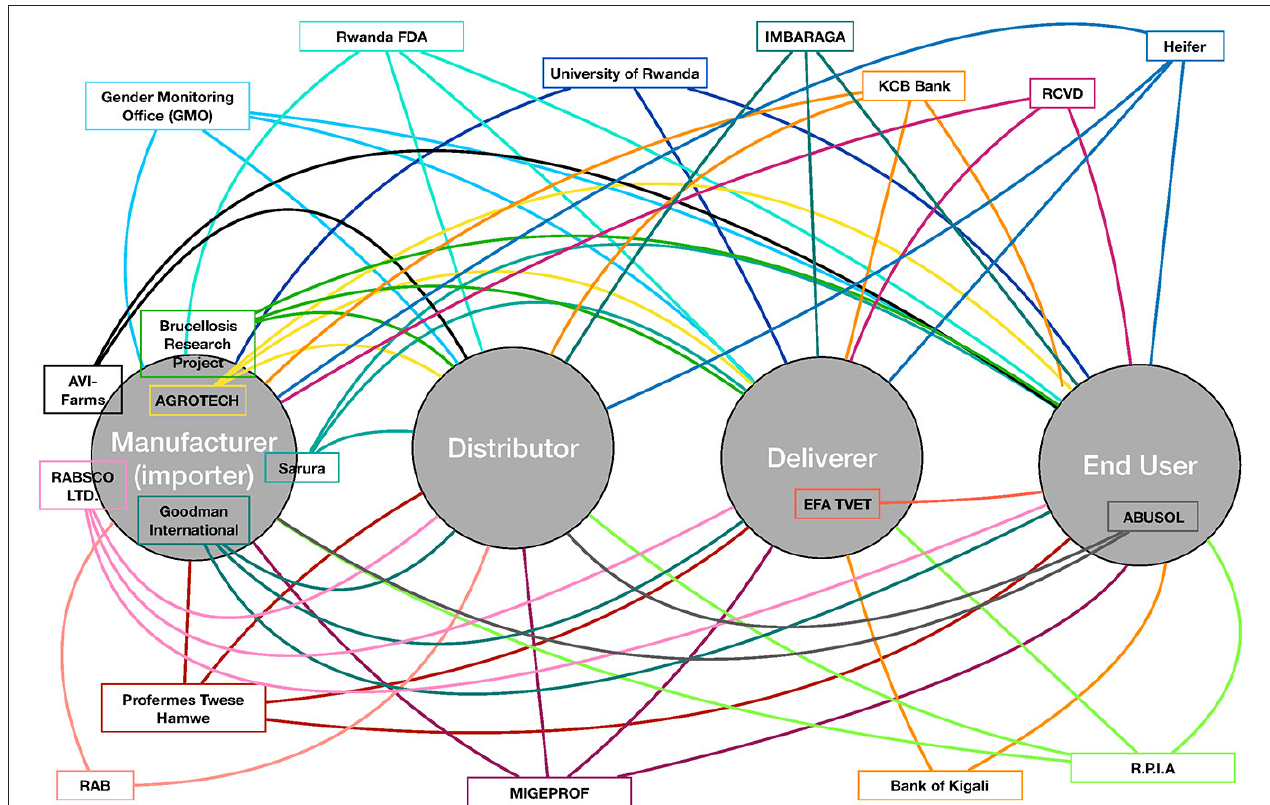
FIGURE 4 | The livestock vaccine value chain ecosystem map created by stakeholders shows how different stakeholders interact at multiple nodes.